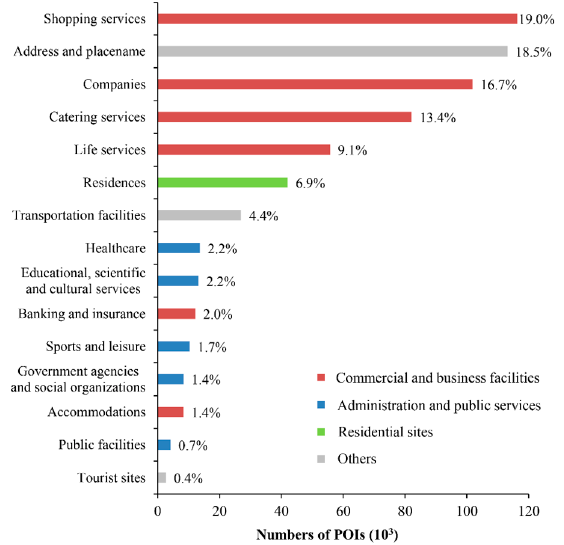
Figure 3. Numbers and proportions of 15 primary categories of points of interest (POIs) in Shenzhen City. These POIs are divided into commercial and business facilities (61.6%), residential sites (6.9%), administration and public services (8.1%), and others (23.4%).